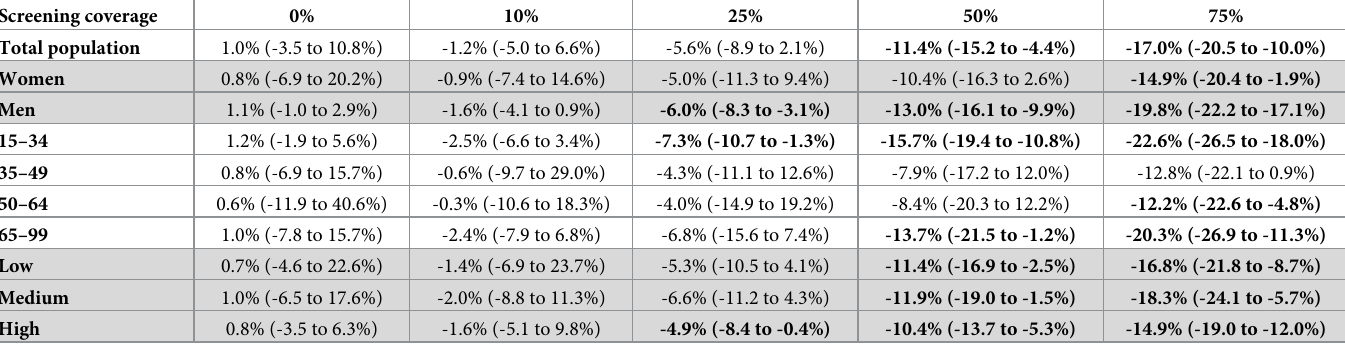
Table 2. Differences in mean drinking levels in different alcohol screening rate scenarios, as compared to baseline scenario at the end of the ten-year simulation period. Screening coverage